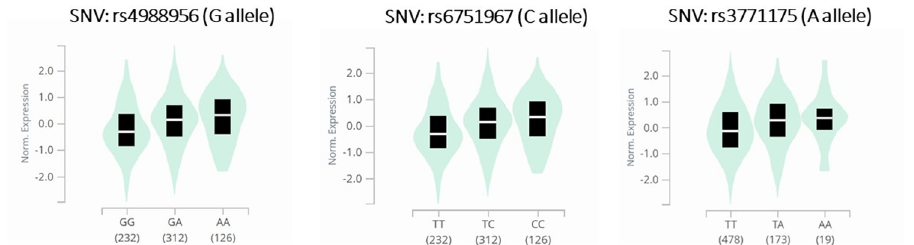
Fig 2. Expression quantitative trait locus (eQTL) analysis. SNVs that significantly decreased the expression in ST2 gene in human whole blood cells. A) The rs4988956 SNV (G allele), either in homozygosis, or in heterozygosis, induced lower gene expression when compared to A allele in homozygosis (p = 0.03). B) The rs6751967 SNV (C allele) led to an increase in the ST2 expression in homozygosis and in heterozygosis (p = 0.03). C) The rs3771175 SNV (A allele) in homozygosis led to an increase in the ST2 expression (p =